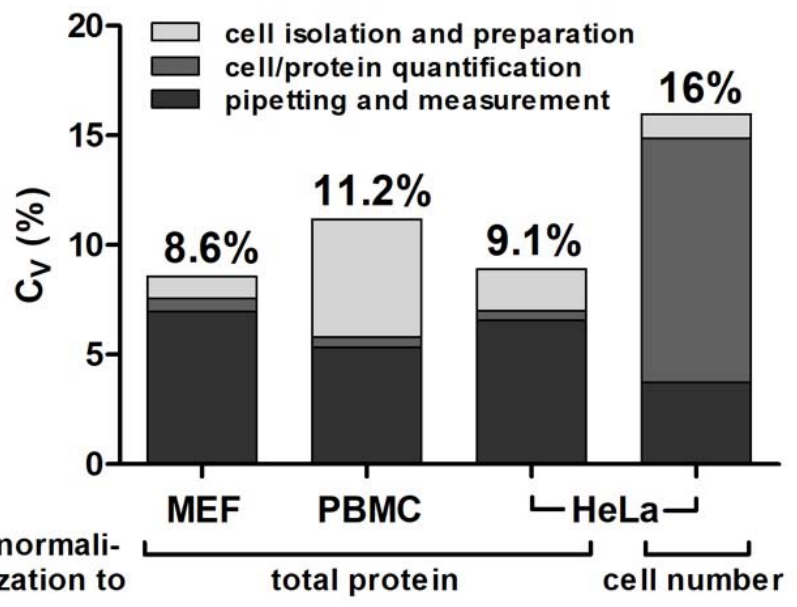
Figure 4. Assay precision. Substrate BD cleavage activity was determined in lysates of mouse embryonic fibroblasts (MEFs), lysates of PBMCs isolated from human blood by Ficoll ® gradient centrifugation, lysates of HeLa cells (sorted for living cells via FACS) with normalization to total protein or cell number as indicated. Total assay variability of the different approaches is shown above the bars. Stacked colors indicate contributions of different error sources (cell isolation and preparation; cell/protein quantification; pipetting and measurement imprecision determined in separate experiments (not shown)).